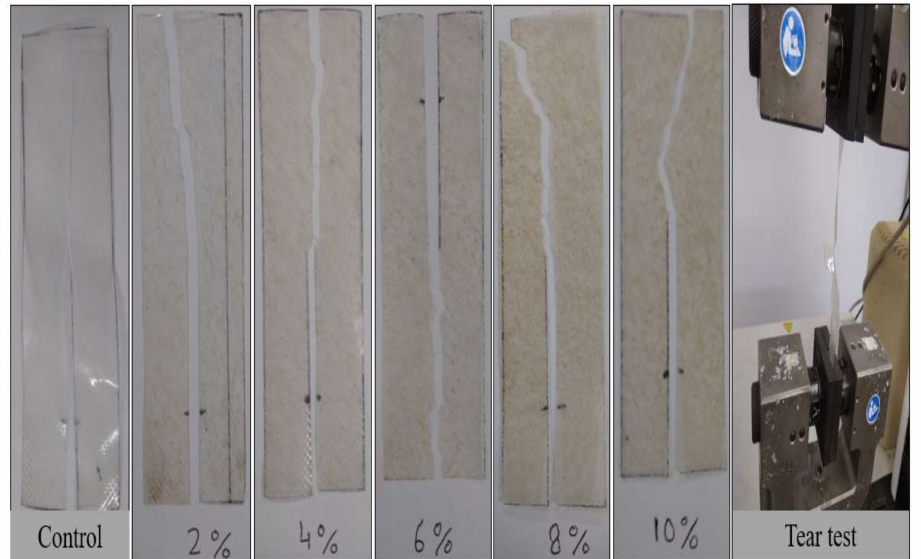
Figure 6. Tested specimens after the tear test of control and composite films with different fiber